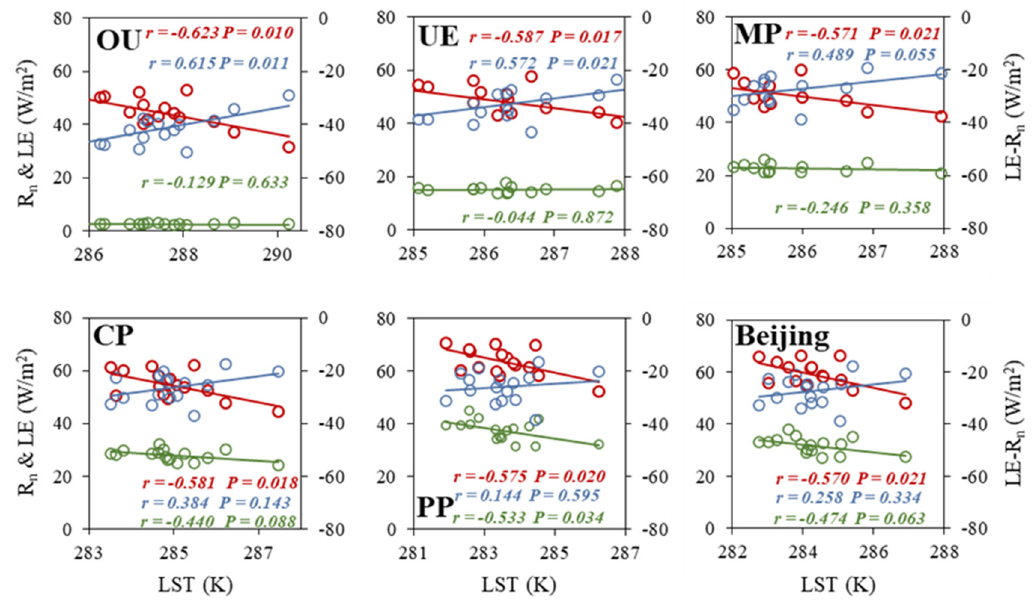
Figure 11. Relationships between temperature (LST), net radiation (R n ), latent heat flux (LE), and LE − R n under various land use types in Beijing from 2000 to 2015. The red dots and lines are the scatter plot of LST and R n ; the green dots and lines are the scatter plot of LST and LE; the blue dots and lines are the scatter plot of LST and LE − R n .